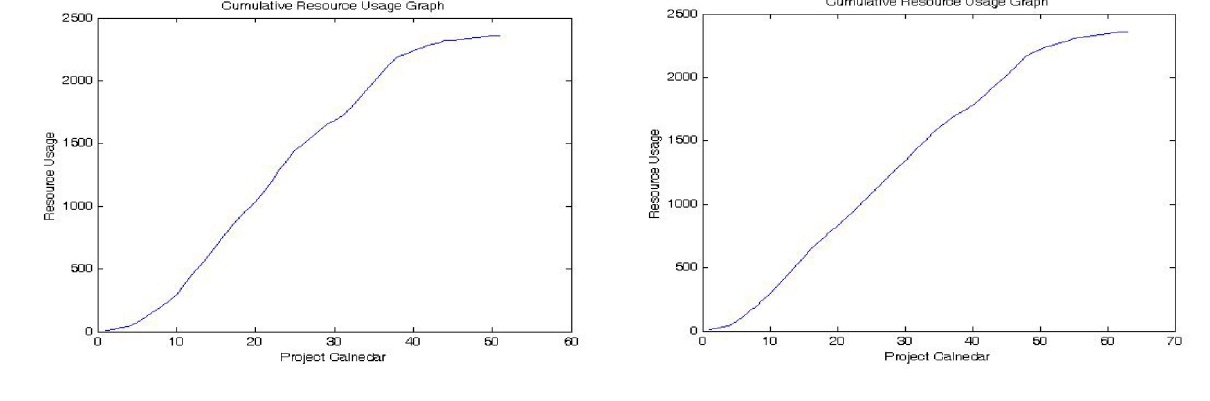
Figure 44. Cumulative resource usage for resource 1 of experiment 3 (relaxed resource constraint)